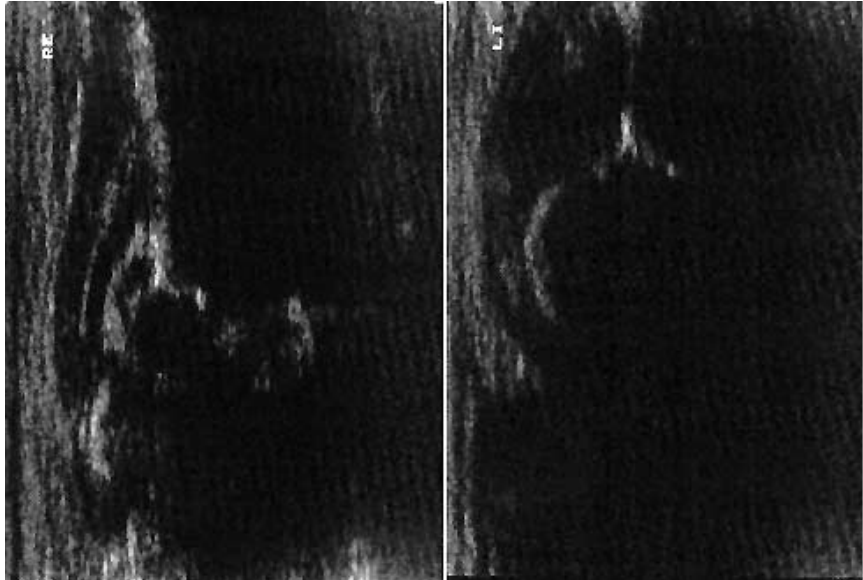
Example of a diagnostic error. Sonographic hip screening of a two-day-old girl (K.S.). The im- ages do not conform to the quality criteria set by Graf in terms of image size and do not show the required landmarks. Nevertheless, an eval- uation was carried out and the hip joint cate- gorised and documented as a Graf Type Ib. Closer examination of the sonogram reveals that the right femoral head is not visibly rest- ing in the acetabulum – the left side is showing a very rare case of capsular laxity Due to this laxity the femoral head frequently pops out and in under a primarily rather well ossified acetabulum. This leads to intra-articular effu- sion and capsular distension (as showing on the sonogram) with recurrent luxations which secondarily will damage the acetabular roof growth plate. For correct diagnosis a stress test should be carried